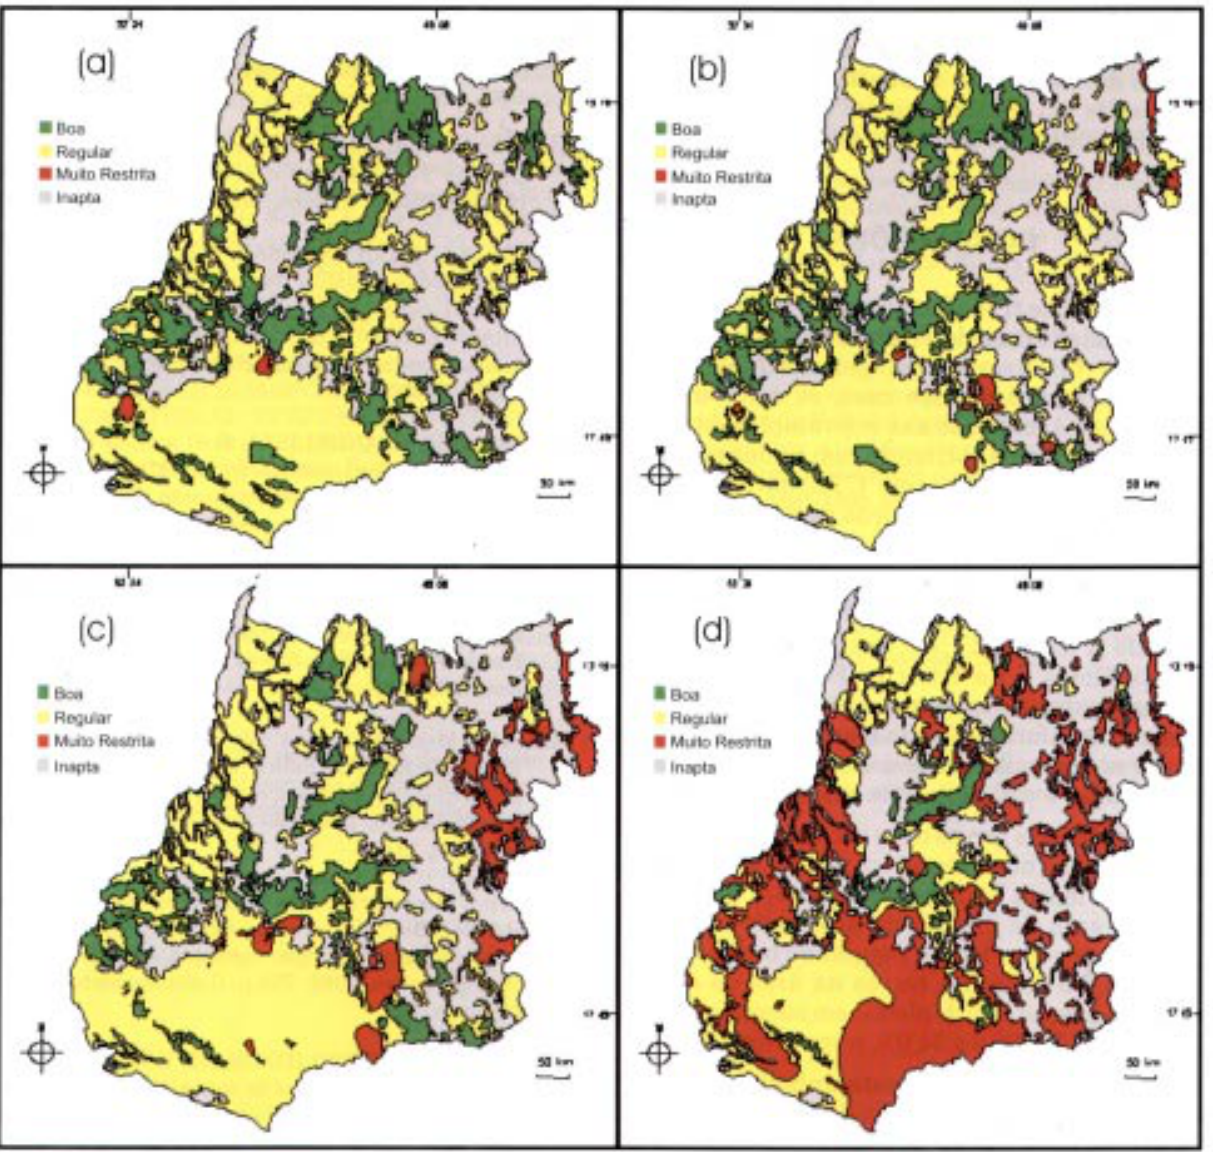
Figura 4. Aptidão edafoclimática das terras de Goiás e do Distrito Federal para o arroz de sequeiro (ciclo de 110 dias) com plantio de: (a) 11 a 20/10; (b) 11 a 20/11; (c) 11 a 20/12; e (d) 11 a